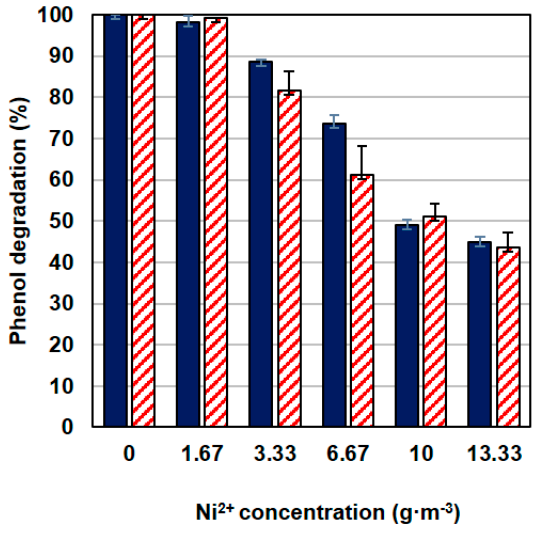
Figure 3. The effect of nickel concentration on phenol degradation at 100 g · m − 3 (dark blue bars) and 300 g · m − 3 (red pattern bars).